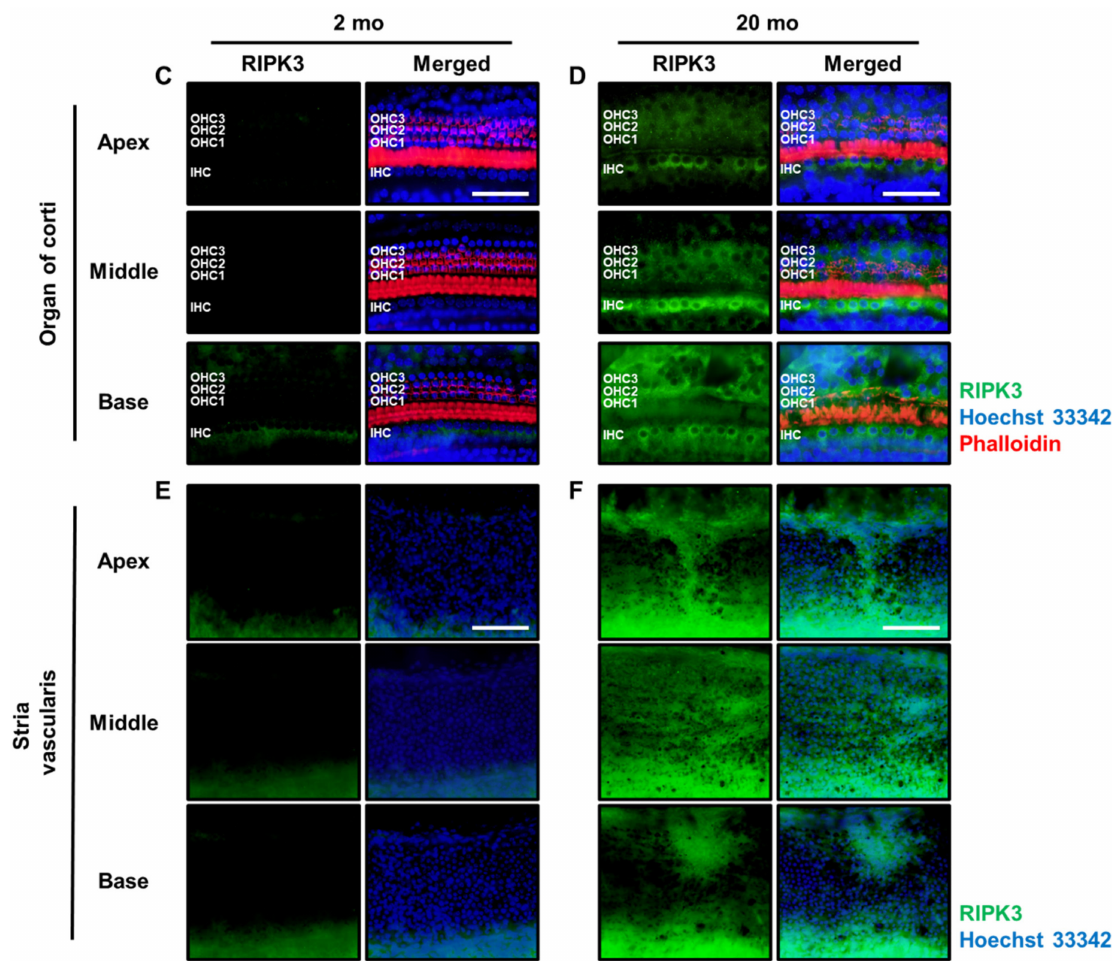
Figure 7. Aging cochlea exerts necroptosis and inflammatory responses. ( A – B ) Gene expression levels of necroptosis ( A ) and proinflammatory cytokines ( B ) and were quantified by qRT-PCR. Graphs represent mean ± S.E.M. * p < 0.05. Unpaired t -test. n = 6–8. ( C – F ) Whole mounts were triple-stained with a Hoechst33342 (blue) specific for nuclei, fluorescence-tagged antibodies against RIPK3 (green) and phalloidin (red) from apex, middle, and base turns of organ of Corti and stria vascularis. Aged cochlea and stria vascularis present significantly increased RIPK3 induction as compared to young ones. Scale bar represents 100 µ m. IHC, inner hair cell; OHC1-3, three rows of outer hair